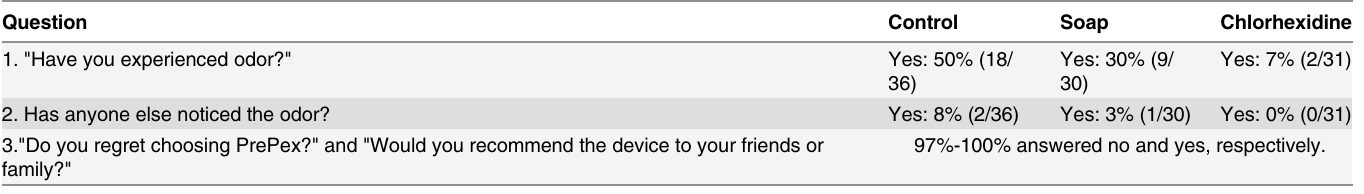
Table 3. Subjects ’ feedback during day 7